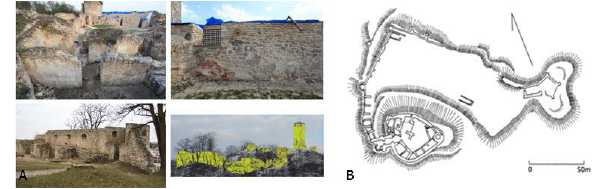
Figure 1: A sketch of the ruins of the castle in Iłża (source: Markiewicz et. al, 2015)